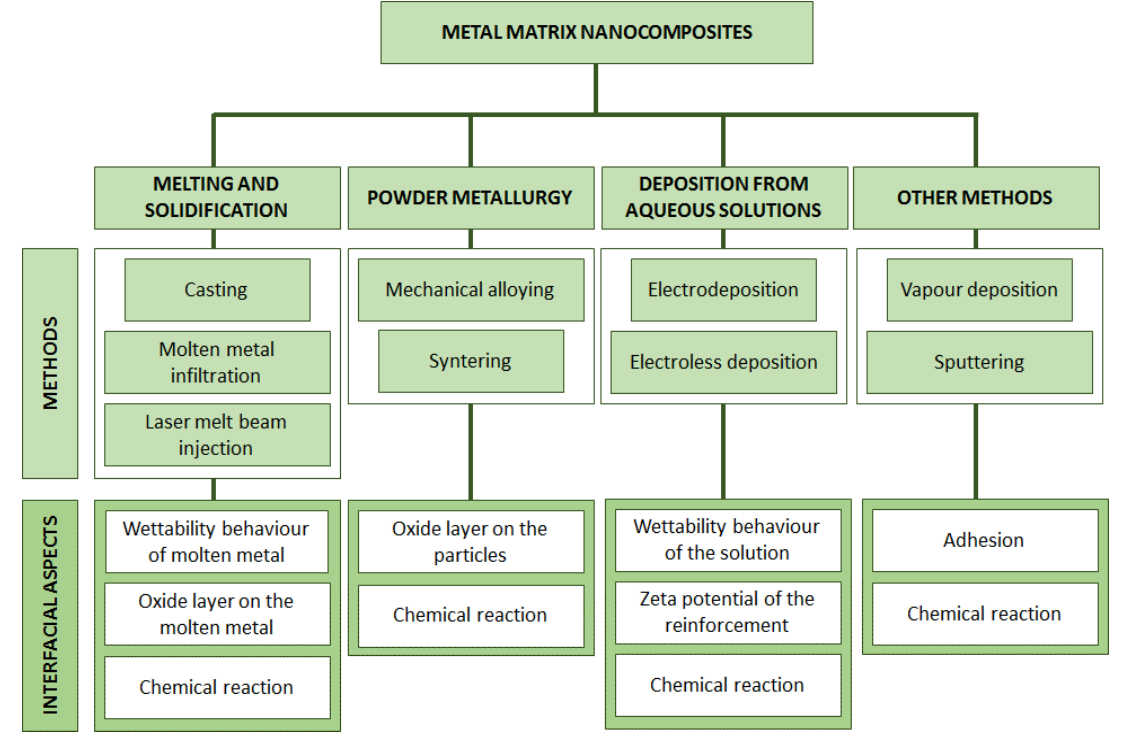
Figure 1. Methods and interfacial phenomena of metal matrix composite preparation.